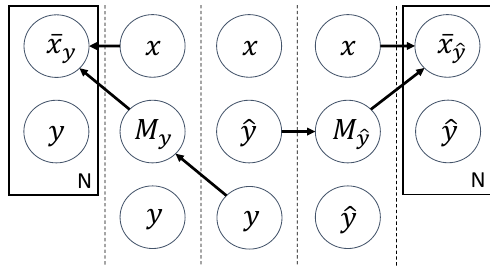
Figure 3. Graphical Model of